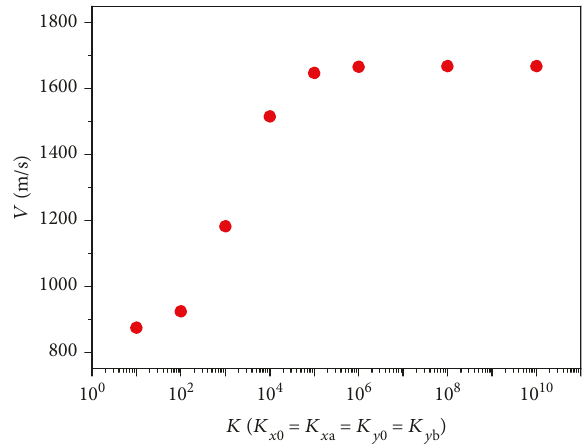
Figure 10: Flutter speed of di ff erent boundary conditions.